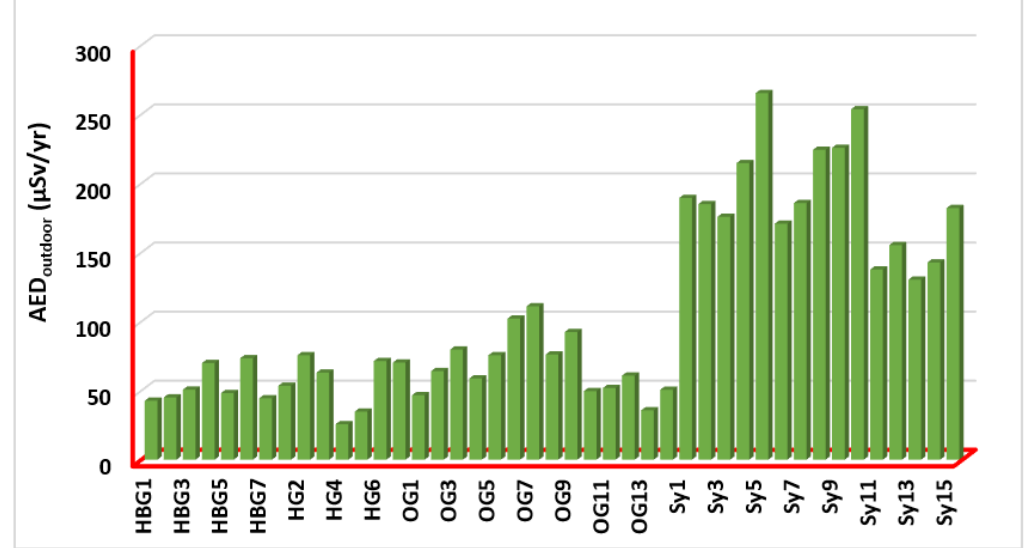
Figure 6. Outdoor annual effective doses (AED outdoor ) for all (7 hornblende biotite gneisses; 7 biotite gneisses; 14 older granites; and 15 syenogranites) rock samples.